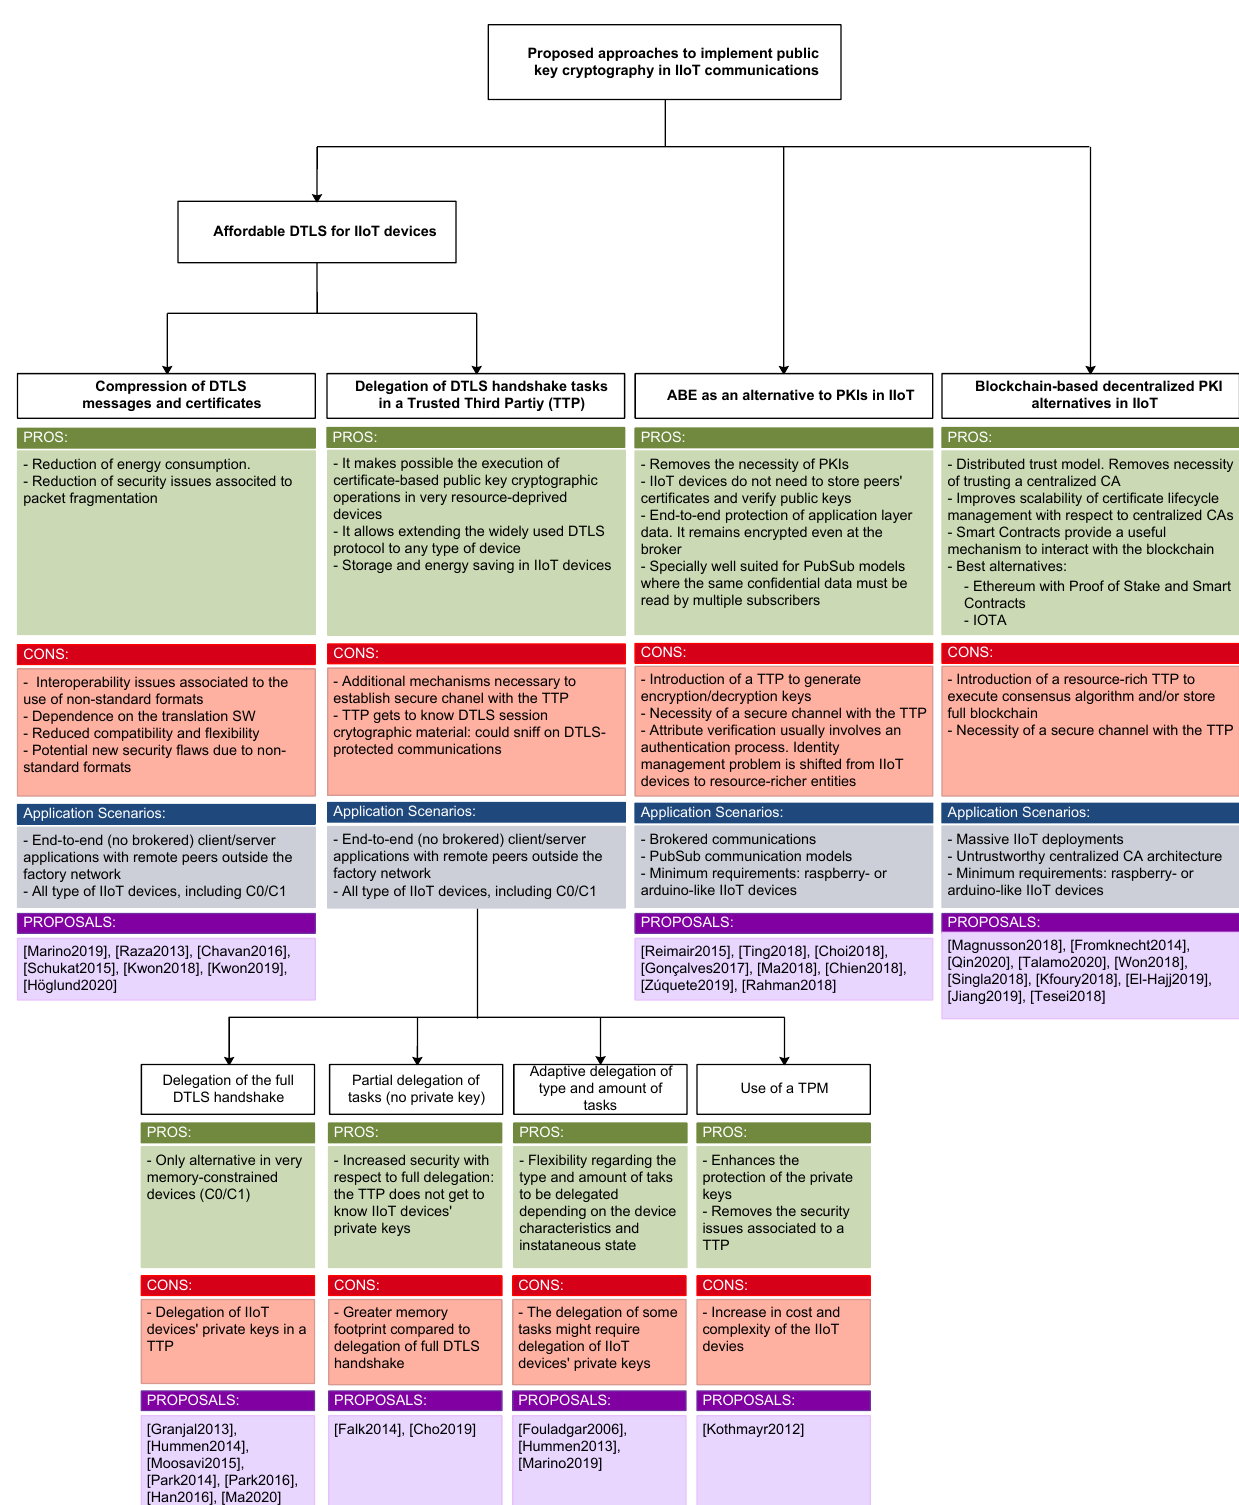
Figure 7. Comparison of pros & cons and different application scenarios of the analyzed approaches